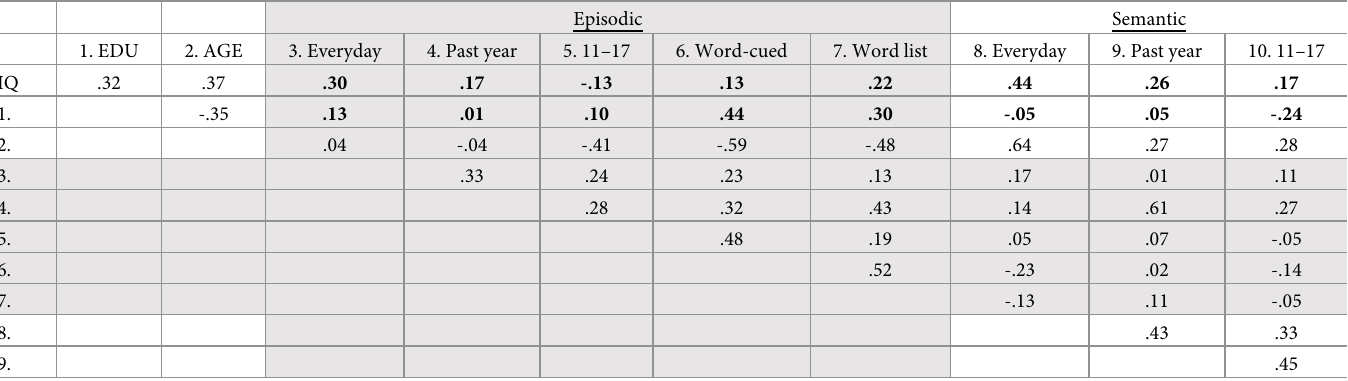
Table 4. Correlations between IQ, education, and memory